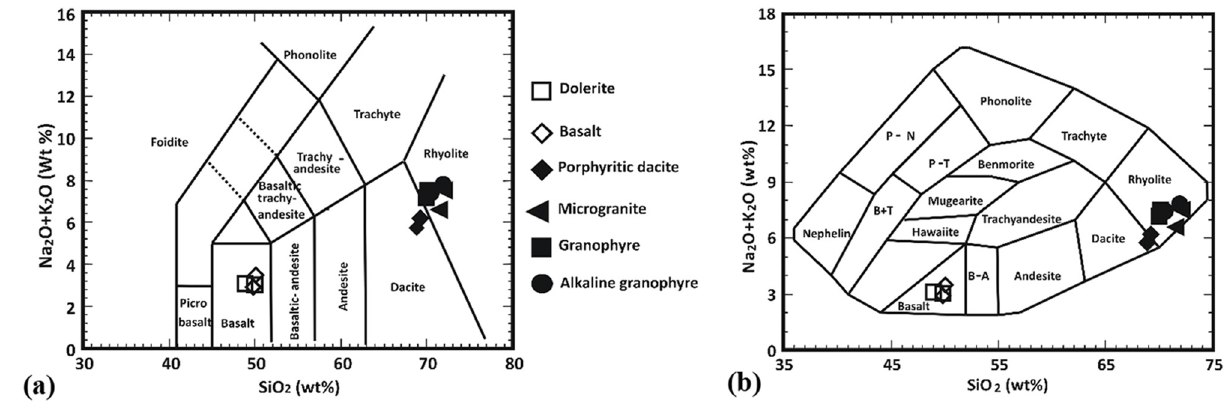
Figure 4: ( a ) Na 2 O + K 2 O vs SiO 2 ( TAS ) diagram for di ff erent dikes, after Le Maitre [ 23 ] . ( b ) Na 2 O + K 2 O vs SiO 2 for the studied dikes ( Cox et al. [ 24 ]) .